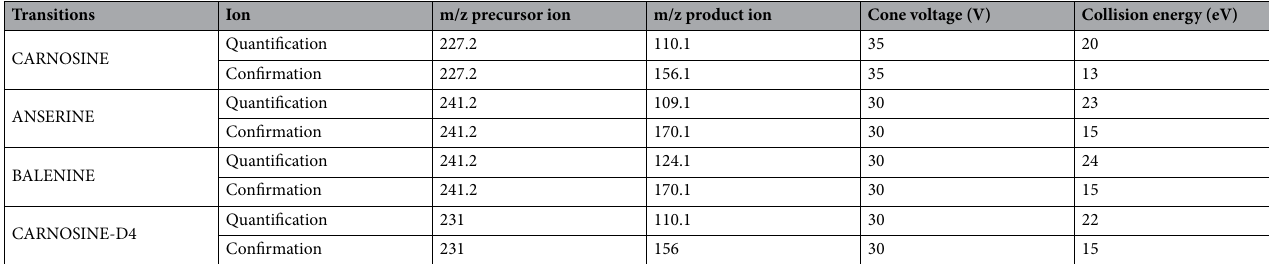
Table 3. Mass spectrometry transitions for HCD quantification. m/z Mass to charge ratio,.